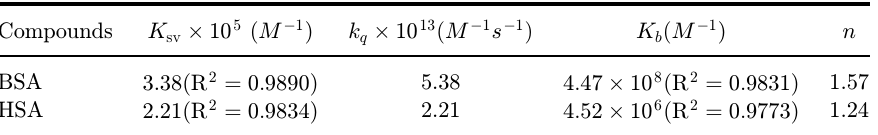
Table 1. Binding and °uorescence quenching parameters for the interaction of AlPc with BSA and